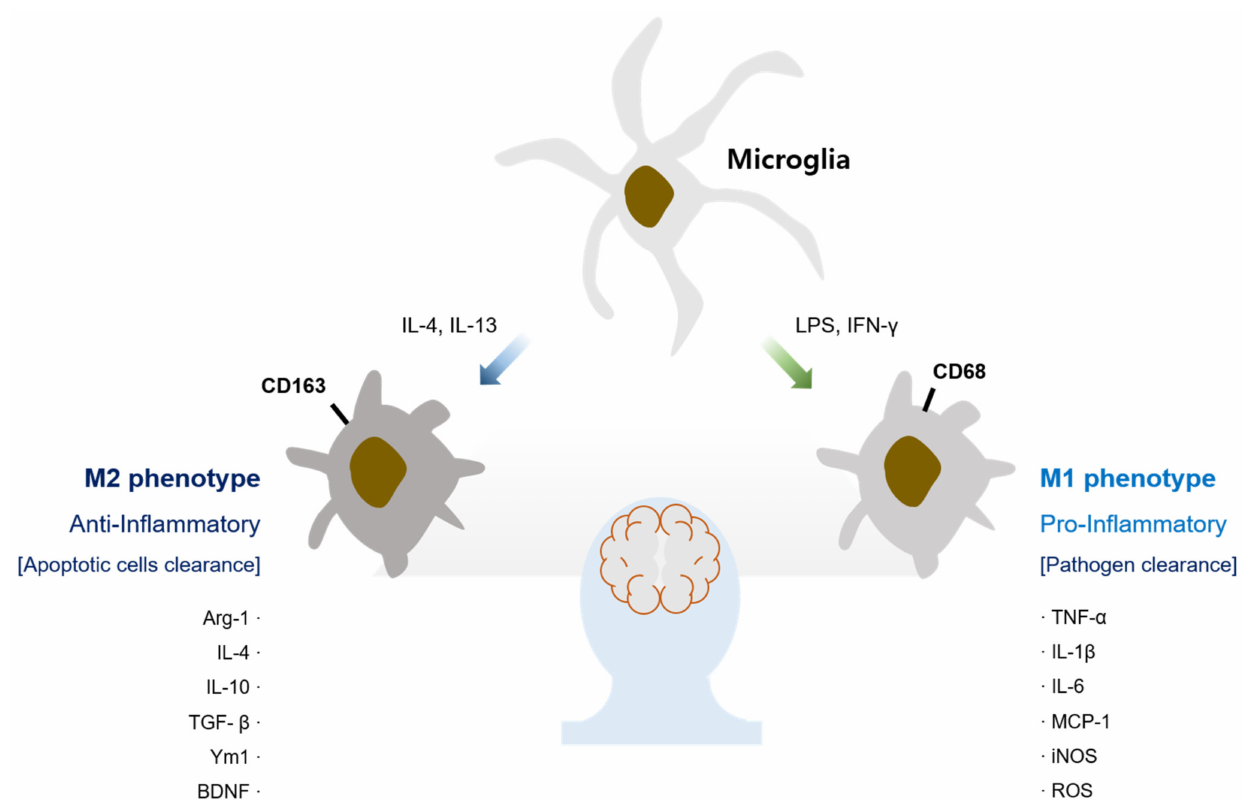
Figure 1. Microglial phenotypes in the brain. In response to stimuli, microglia can be classified into M1 and M2 phenotypes expressing a variety of surface markers and inflammation-associated molecules. The binding of LPS and Th1 cytokines (IFN- α and TNF- α ) to receptors on microglia leads to M1 phenotype microglia, which generate pro-inflammatory molecules. Th2 cytokines (IL-4 and IL-13) promote M2 phenotype microglia, which in turn generate anti-inflammatory molecules. This process takes place in a variety of